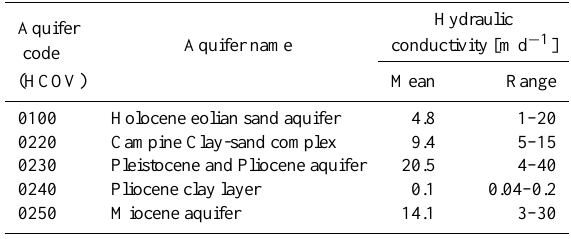
Table 1. Overview of the hydrostratigraphy of the study area Aquifer